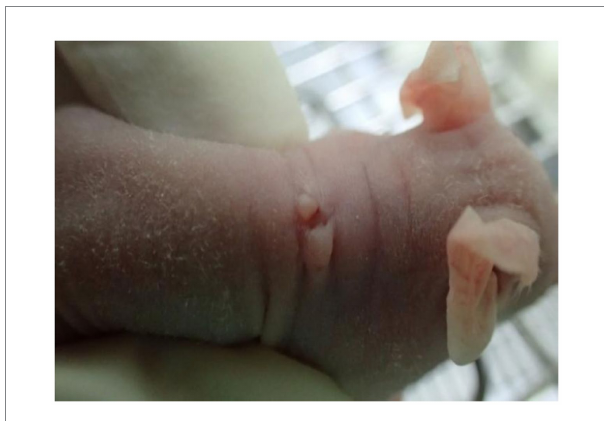
FIGURE 1 A representative image of a nude mouse after the inoculation of CA tissue. After CA tissue inoculation in the nude mouse, the skin around the operational area was dry with no discharge, and the wart was slightly raised above the skin surface, resembling the skin of a nude mouse, with a hard texture when touched. CA, condylomata acuminata.